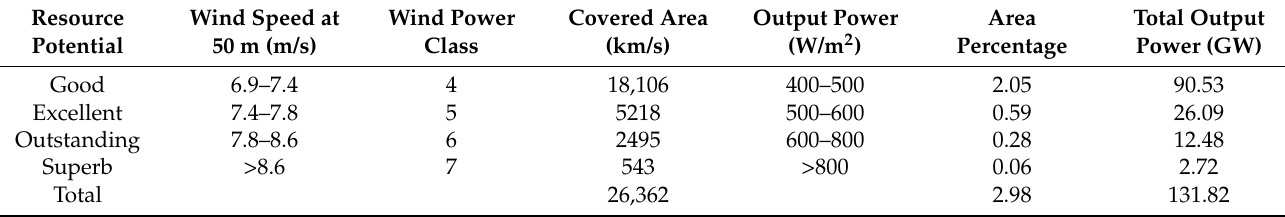
Table 3. Analysis of Pakistan’s wind power capacity at 50 m [83].